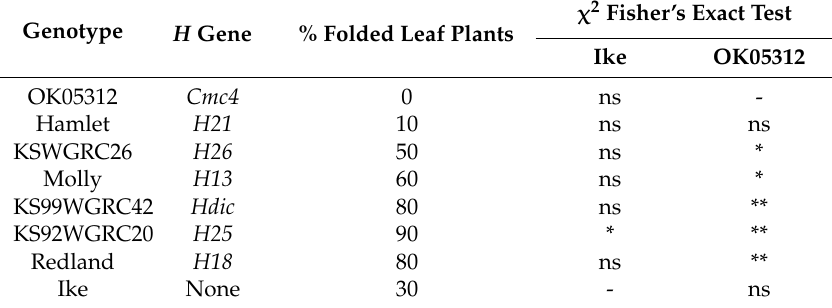
Table 2. Percent A. tosichella biotype 1—induced folding in wheat plants with M. destructor resistance genes, the OK05312 ( Cmc4 ) resistant control and the susceptible Ike control at 14 days post— A. tosichella infestation in a no-choice